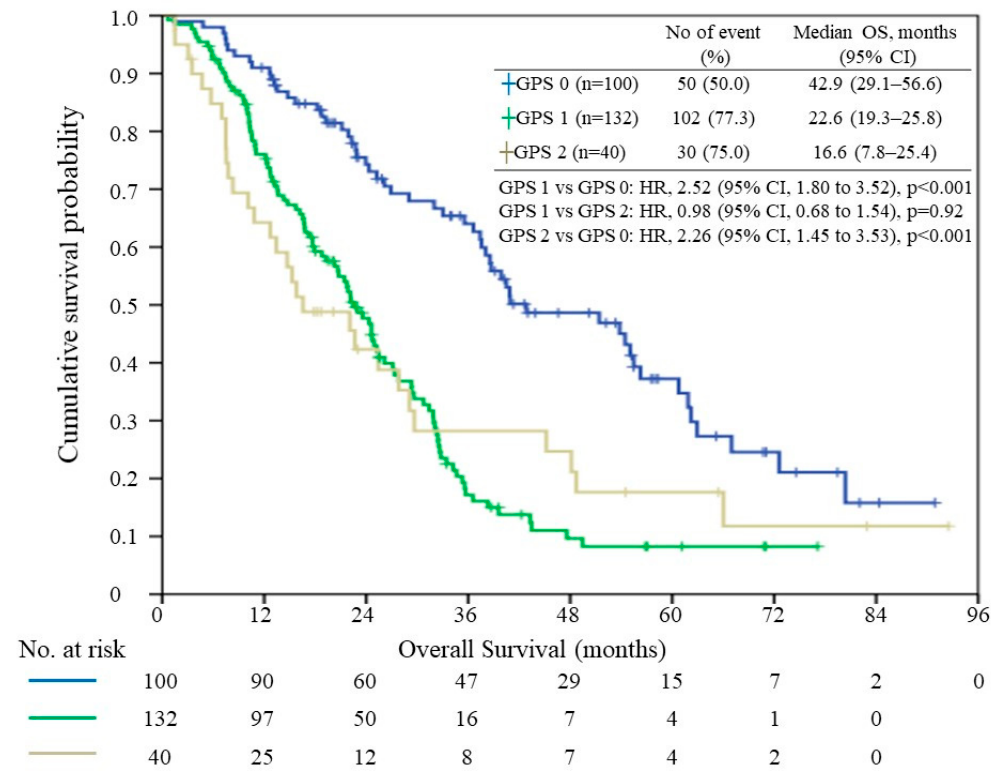
Figure 2. Relationship between the Glasgow prognostic score (GPS) and overall survival (OS). HR, hazard ratio; CI, confidence interval.